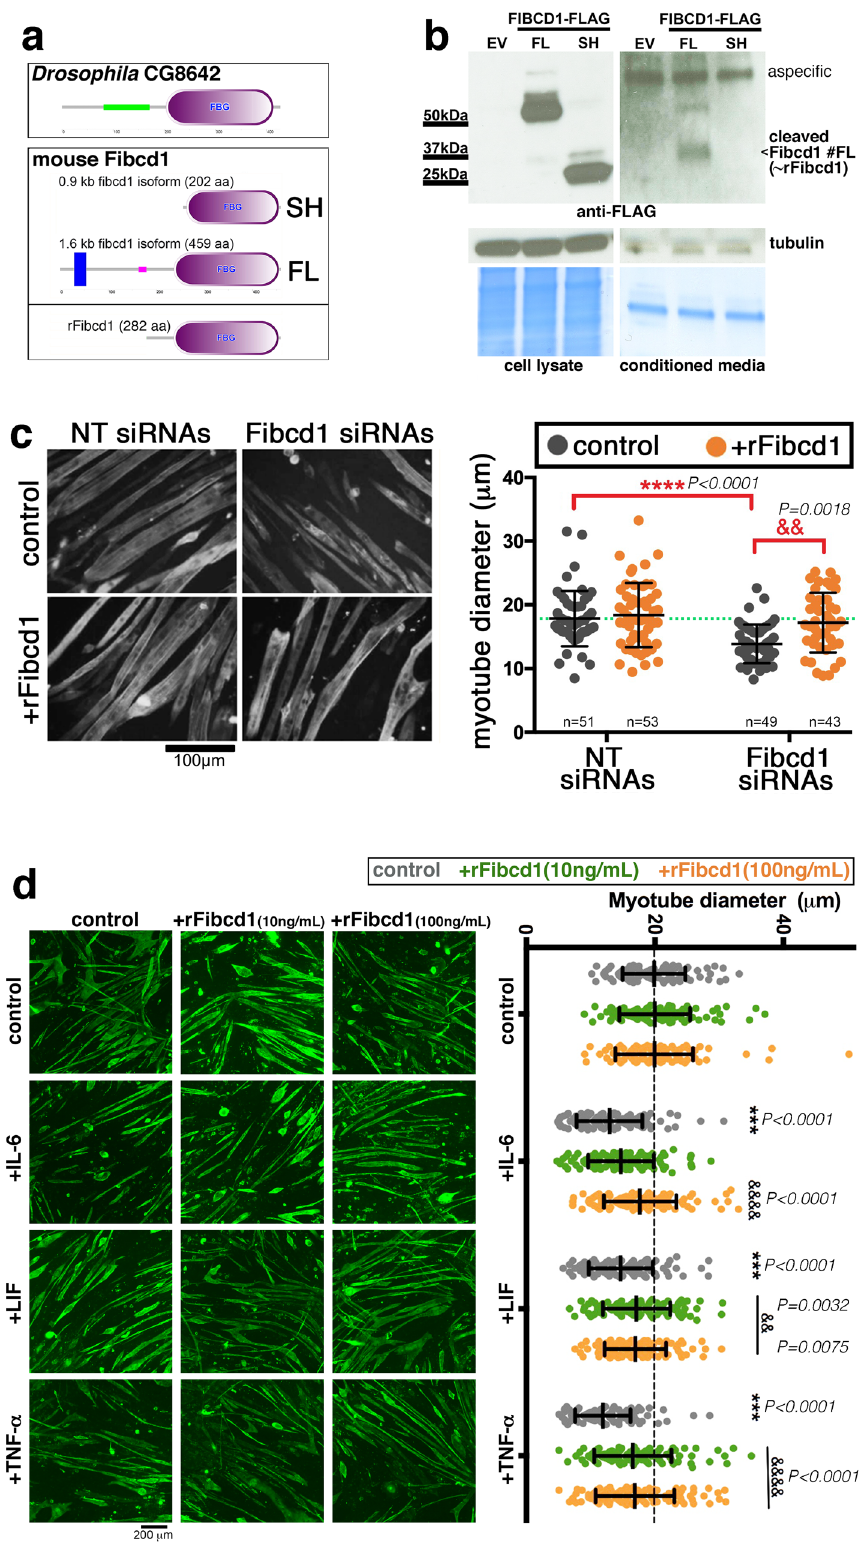
rFibcd1 does not promote ERK signaling in a set of cancer cells . ERK is a major driver of tumorigenesis 87 and therefore interventions that combat muscle wasting via ERK signaling may be hindered by the side effect of promoting cancer cell proliferation 88 . On this basis, we next examined whether rFibcd1 increases P-ERK levels also in cancer cells. To this purpose, we